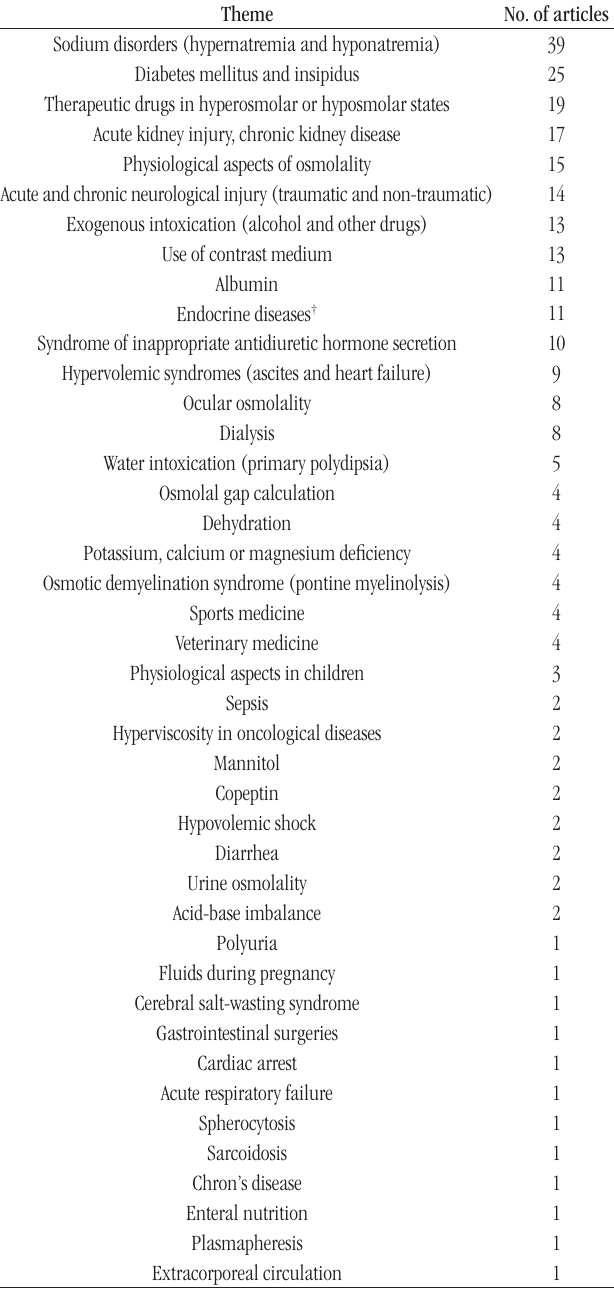
taBLE 1 − Inventory of the 272 articles found at the PubMed database, using the combined filter with the terms “serum osmolality article review” and “plasmatic osmolality review